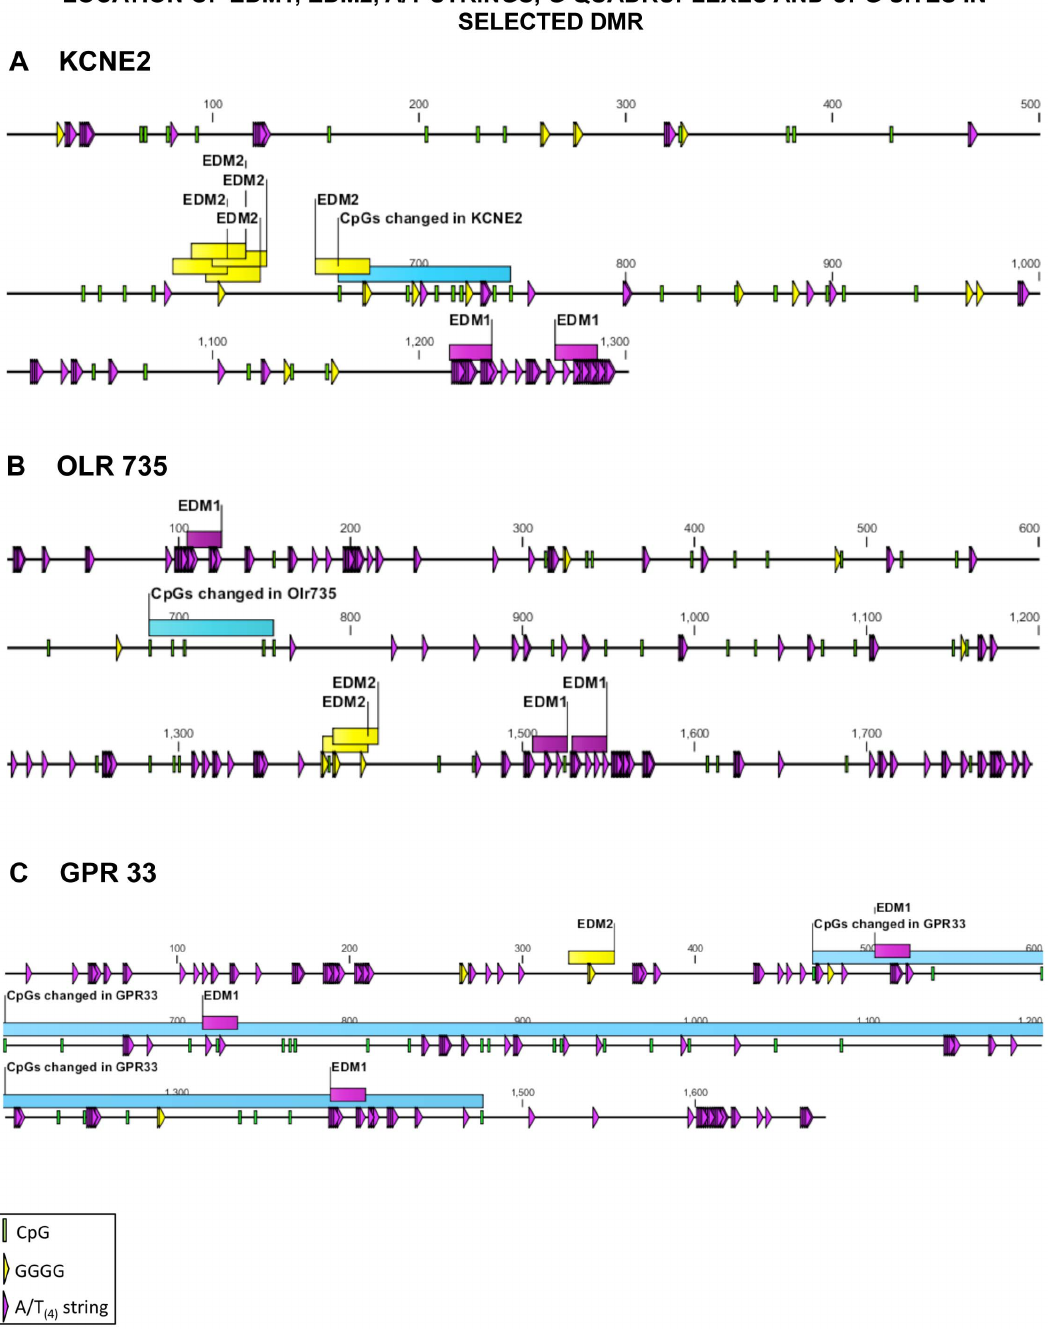
EDM2, and purple box EDM1.